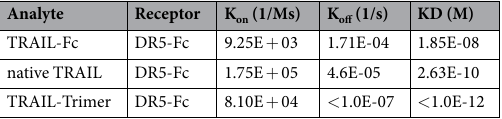
Table 1. Affinity and rate constants of TRAIL-Trimer, TRAIL-Fc and native TRAIL with